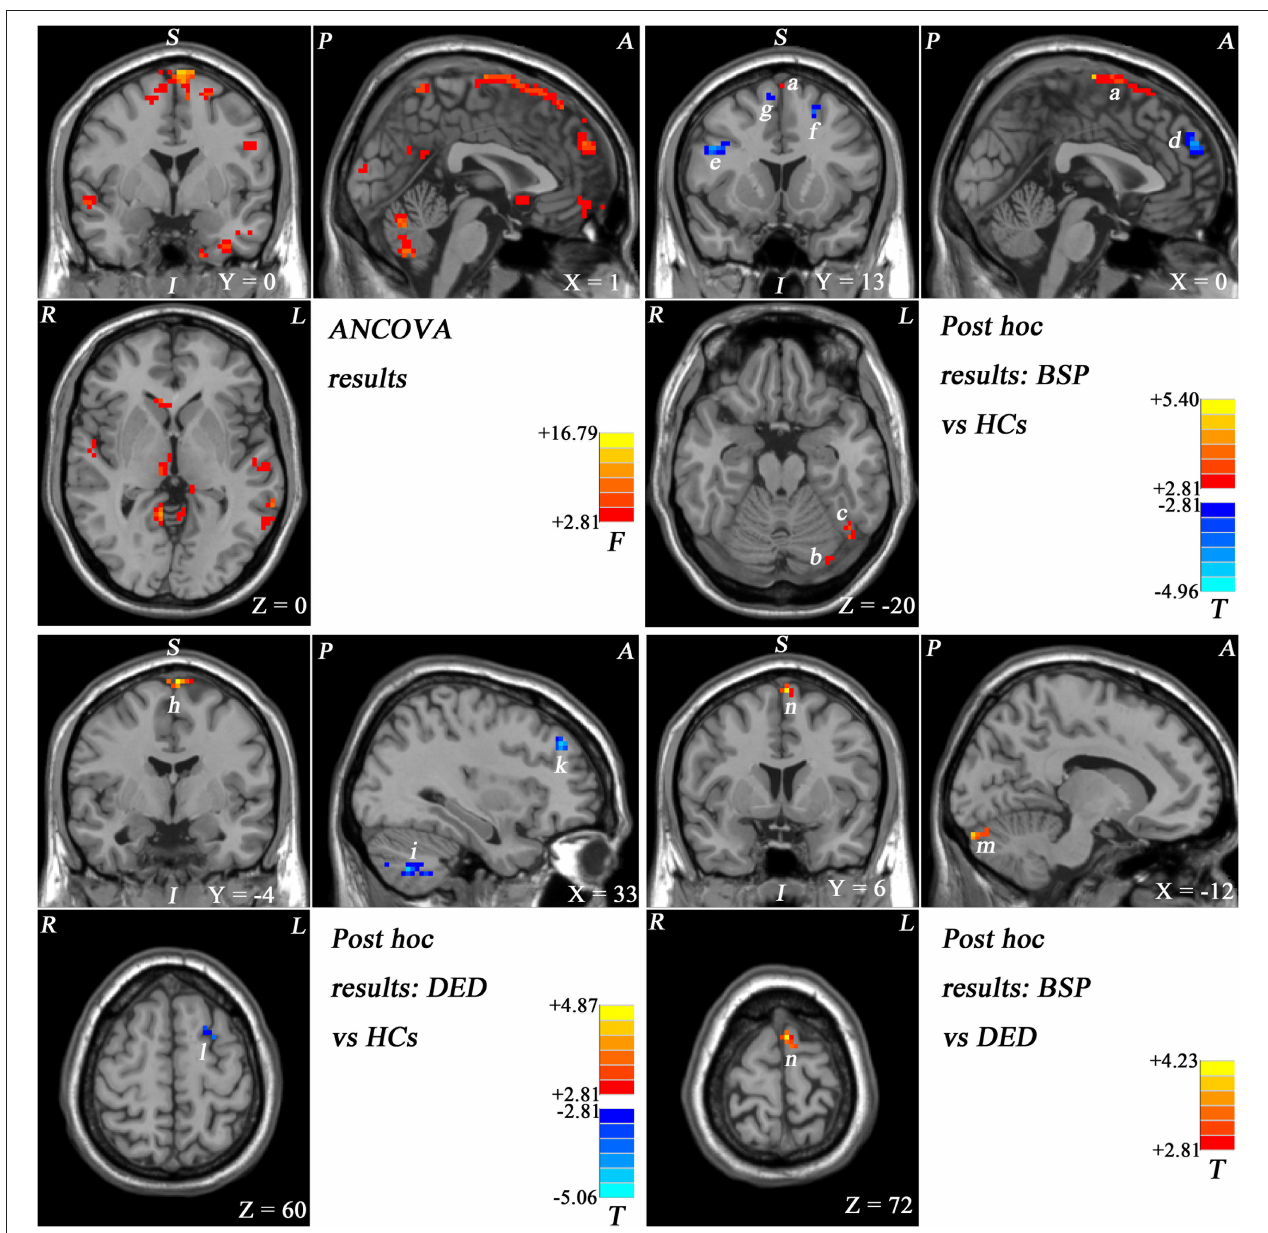
FIGURE 1 | Statistical maps showing ALFF values differences in different brain regions across studied groups. Red and blue represent higher and lower ALFF, respectively. The color bars indicate the F -values from the ANOVA analyses and the T -values from post-hoc analysis between each pair of groups. (a) Bilateral SMA, (b) left cerebellar crus I, (c) left fusiform gyrus/cerebellar crus I, (d) bilateral superior MPFC, (e) right inferior frontal gyrus, (f) left middle frontal gyrus, (g) right superior frontal gyrus, (h) bilateral SMA, (i) right cerebellar VIII/VIIb, (k) right middle frontal gyrus, (l) left middle frontal gyrus, (m) left cerebellar crus I, and (n) left